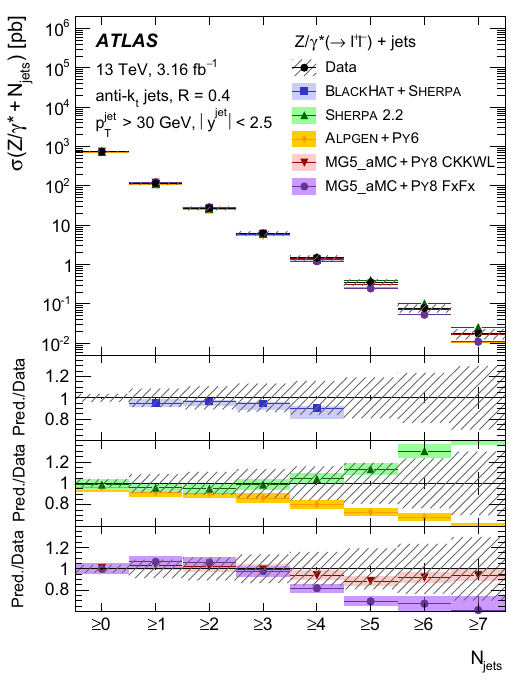
Fig. 4 Measured cross section as a function of the inclusive jet multiplicity ( left ) and ratio for successive inclusive jet multiplicities ( right ) for inclusive Z + jets events. The data are compared to the predictions from BlackHat+Sherpa , Sherpa 2.2 , Alpgen+Py6 , MG5_aMC+ Py8 CKKWL, and MG5_aMC+ Py8 FxFx. The error bars correspond to the statistical uncertainty, and the hatched bands to